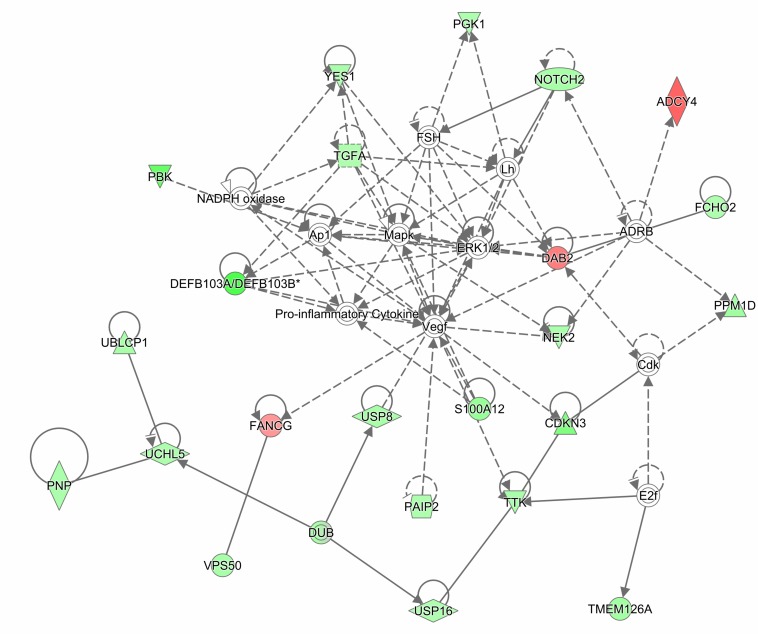
Ingenuity Pathway Analysis (IPA) network diagram of differentially expressed genes in patient vs. control buccal biopsies. The gene expression analysis was conducted on 4 APECED patient and 2 control buccal biopsy samples. Differentially regulated genes were analyzed by IPA. Network analysis with the highest score consisted of 23 focus molecules and 12 interconnecting molecules. Network, which had the highest score (score 51), was categorized by IPA function: “antimicrobial response, cellular function and maintenance, inflammatory response.” Two genes were considered to be connected if there was a path in the network between them. The intensity of the gene color indicates the degree of upregulation (red) or downregulation (green) of a given gene. The legend of figure shapes and relationships can be found in Supplementary Figure 5.